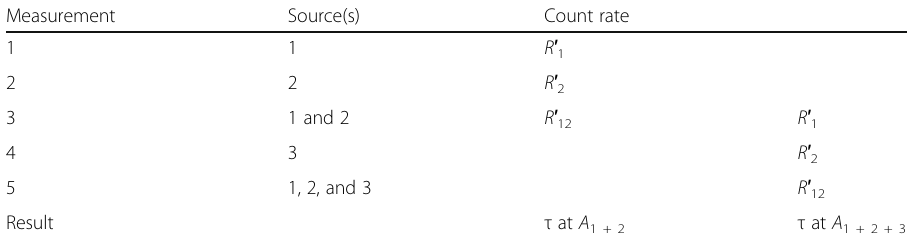
Table 1 Overview of combinations of sources and resulting τ values